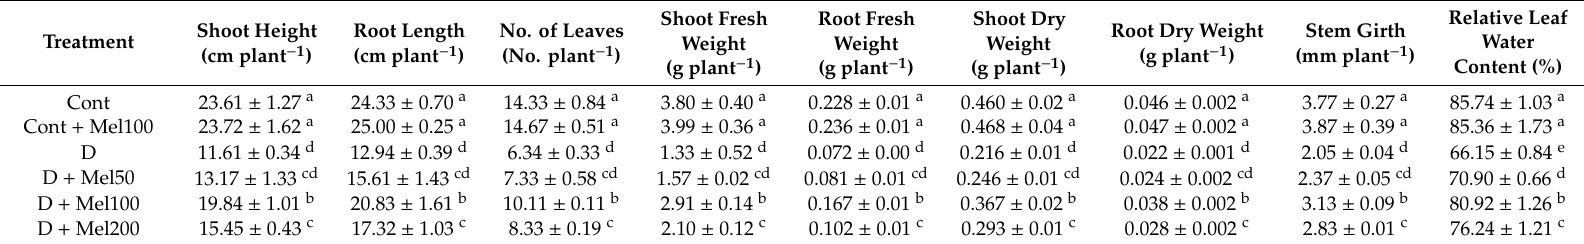
Table 1. E ff ect of melatonin supplementation on the growth parameters and the relative water content of Tartary buckwheat plants under drought stress.